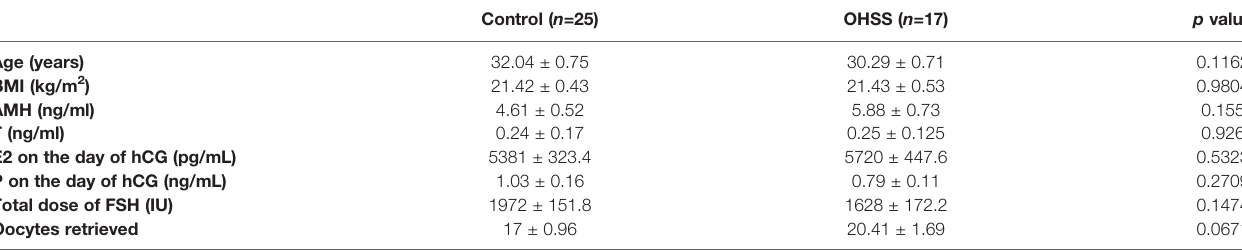
Values are presented as mean ±